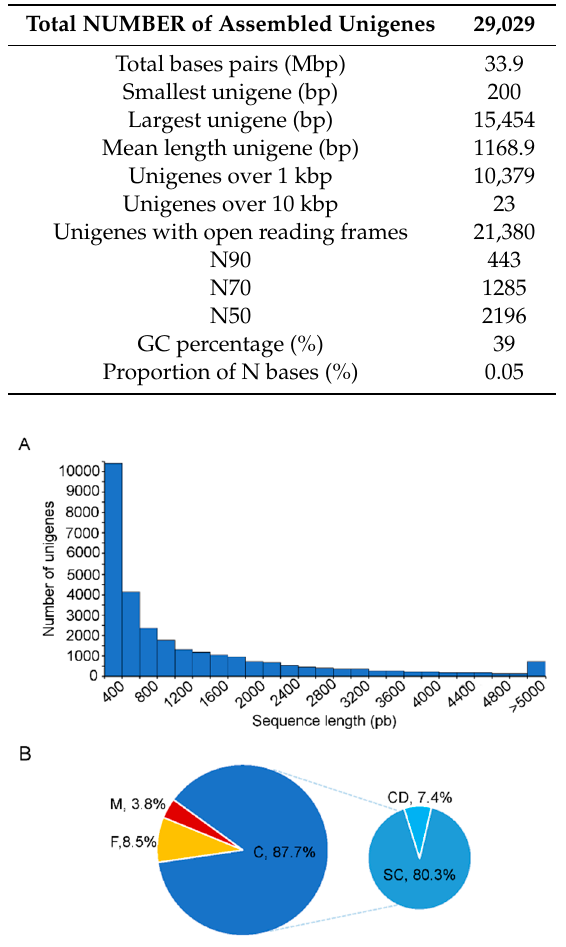
Table 1. Summary statistics of Z. subfasciatus transcriptome assembly.